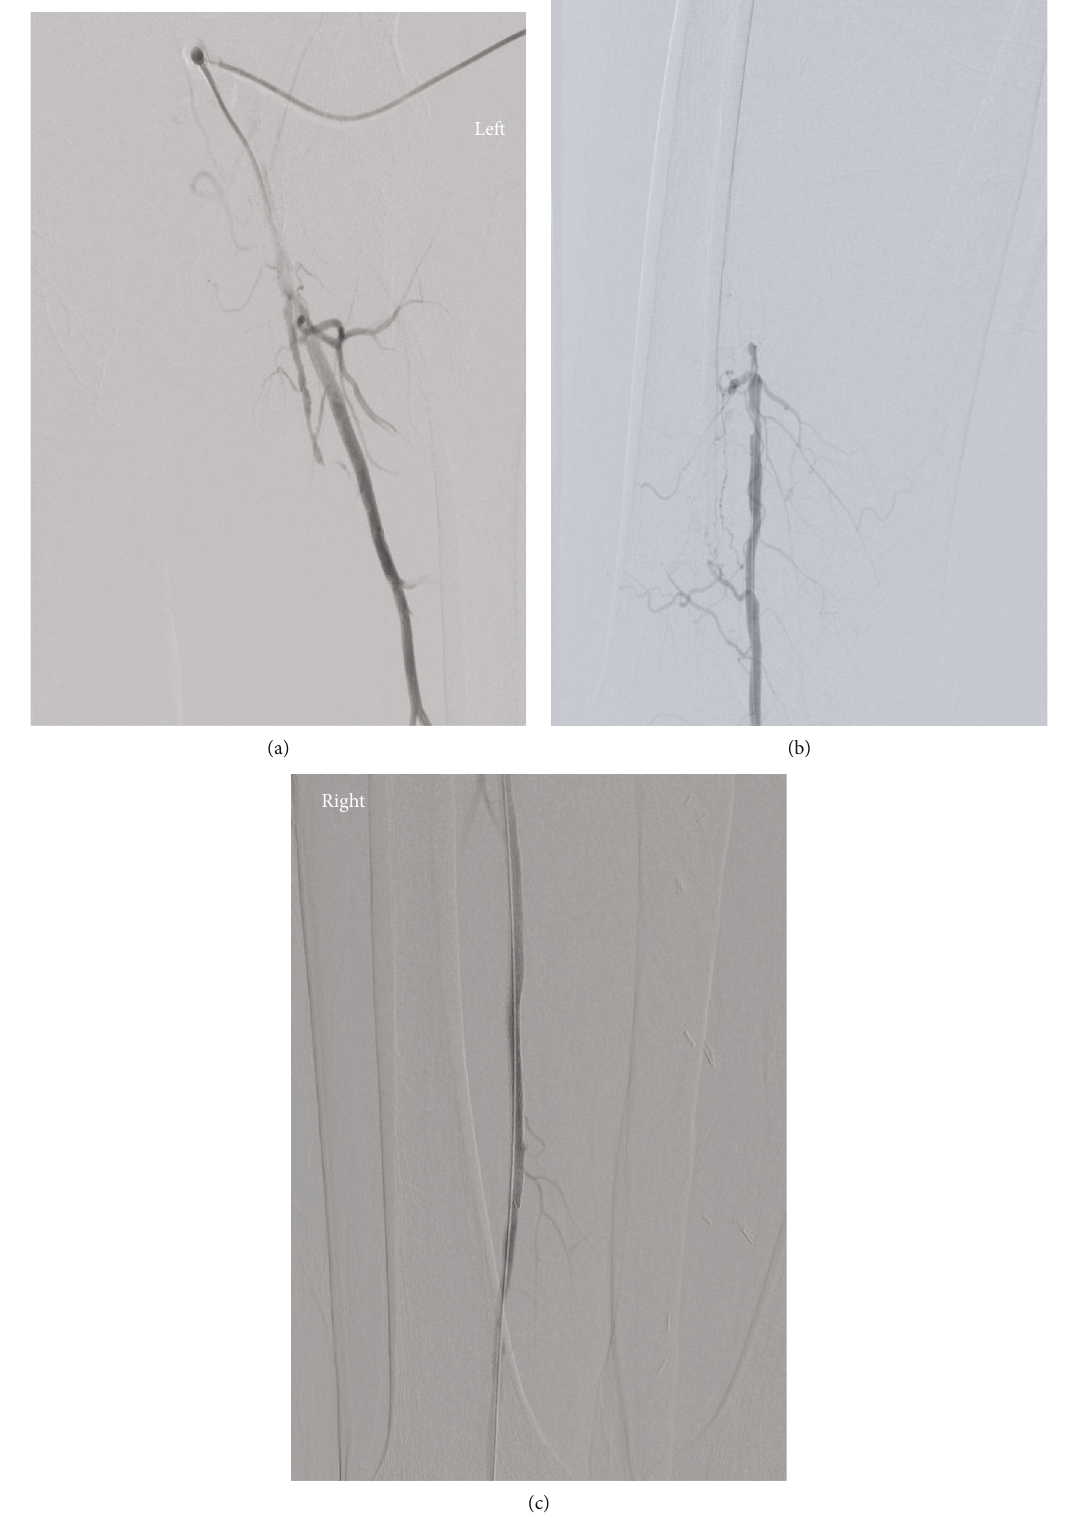
Figure 2: (a, b) Prerecanalization; (c)